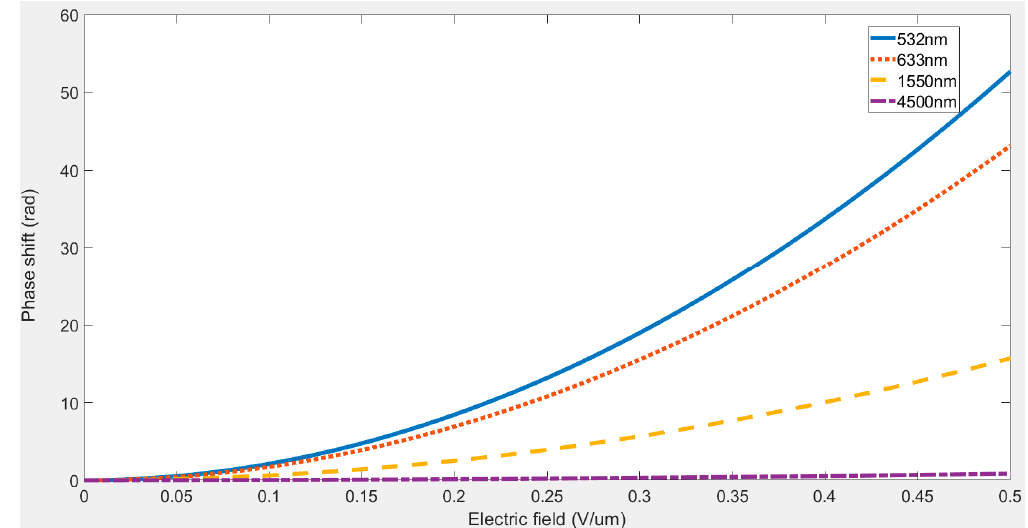
Figure 23. The phase retardance versus applied electric field on PMN-PT ceramic for four wavelengths (532, 633, 1550, and 4500 nm).